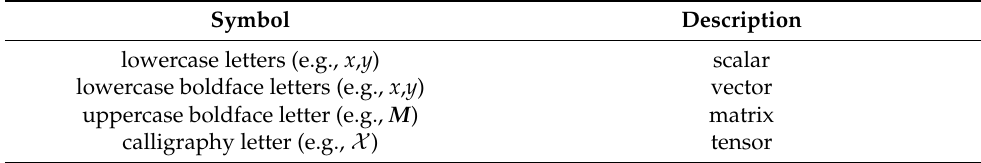
Table 1. The symbols and their corresponding description used in this paper. Symbol Description lowercase letters (e.g., x , y ) scalar matrix